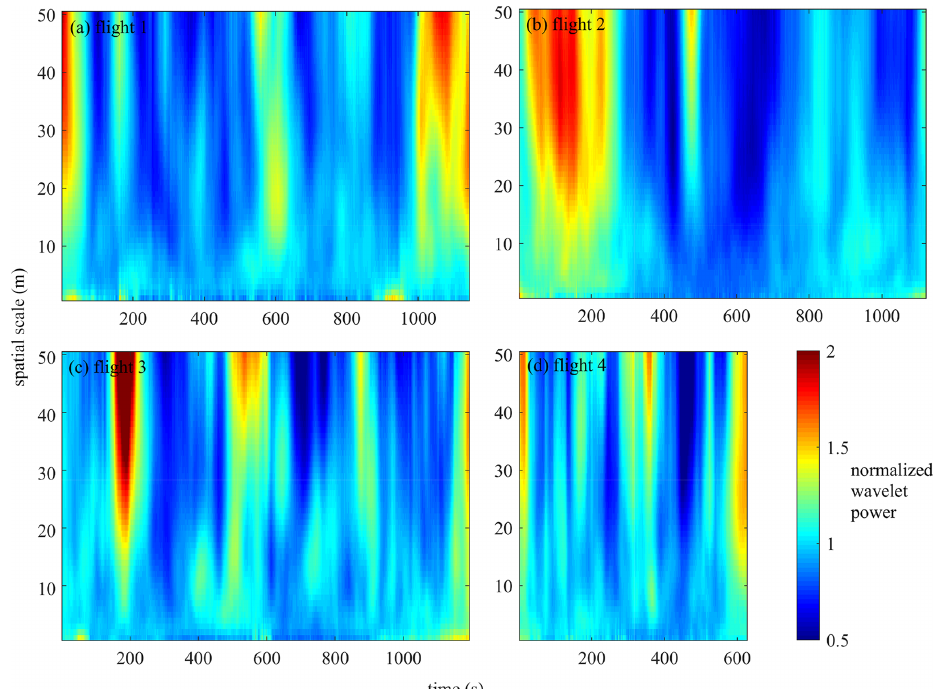
Figure 9. Scalograms of 2D continuous wavelet transforms on the spatial scales of 1–50m. Absolute values of wavelet power are taken in order to average over the negative and positive T excursions and normalized by the average absolute power at the respective